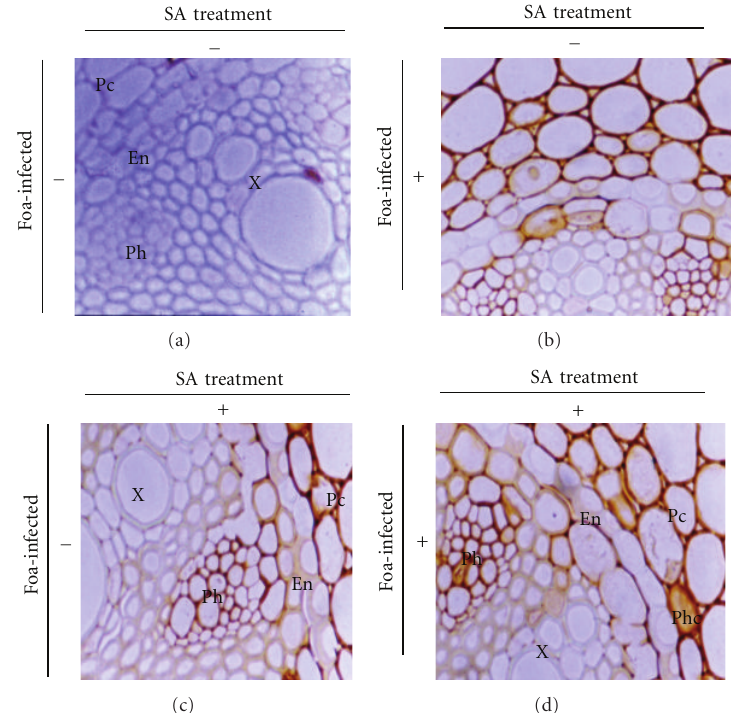
Figure 3: Cytochemical localization of peroxidase activity in date palm root tissues of JHL cultivar revealed by brown deposits after DAB staining. (a) control plants (UU; × 40); (b) infected plants (UI; × 60); (c) SA-treated roots (TU; × 60); (d) SA-treated and Fusarium oxysporum f. sp. albedinis -infected plants (TI; × 60). X: xylem vessels; Ph: phloem; En: endodermic cells; Pc: cortical parenchyma cells; Phc: Phenolic- storing cells.